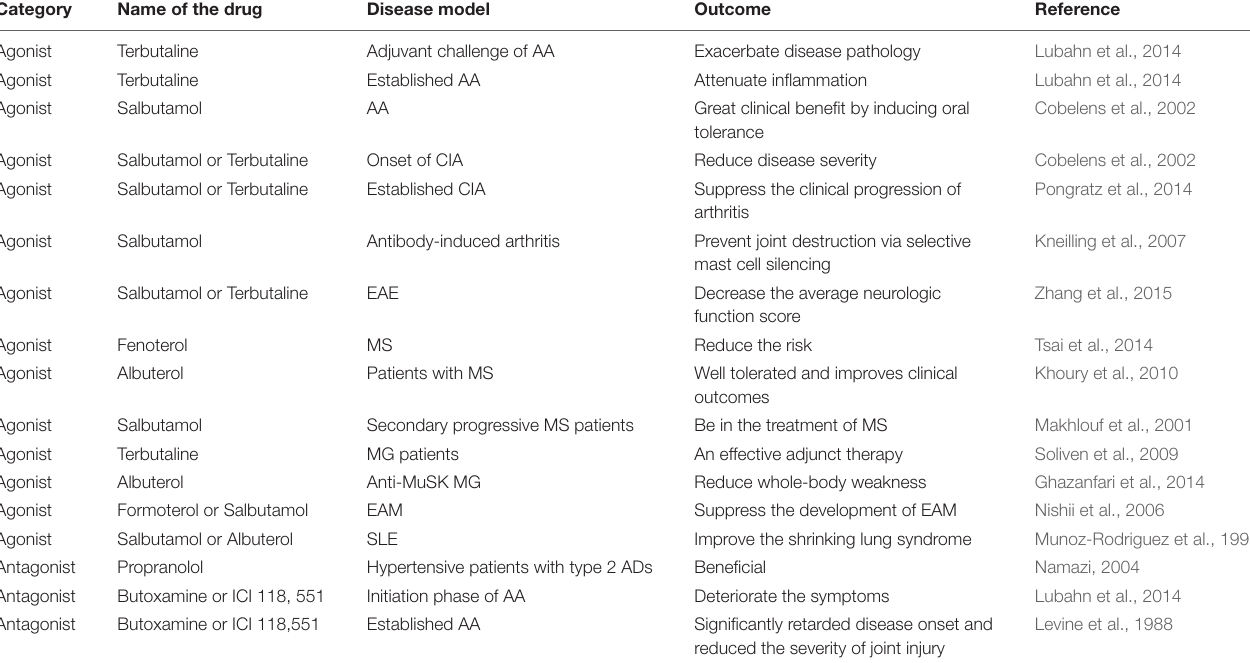
TABLE 1 | Effect of β 2-agonist or β 2-blocker on